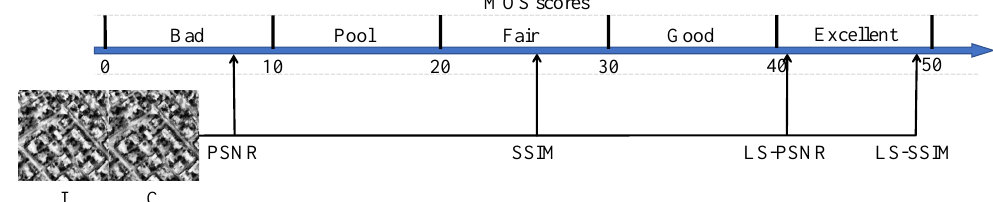
Figure 8. Visual illustration of R IQA model predicted